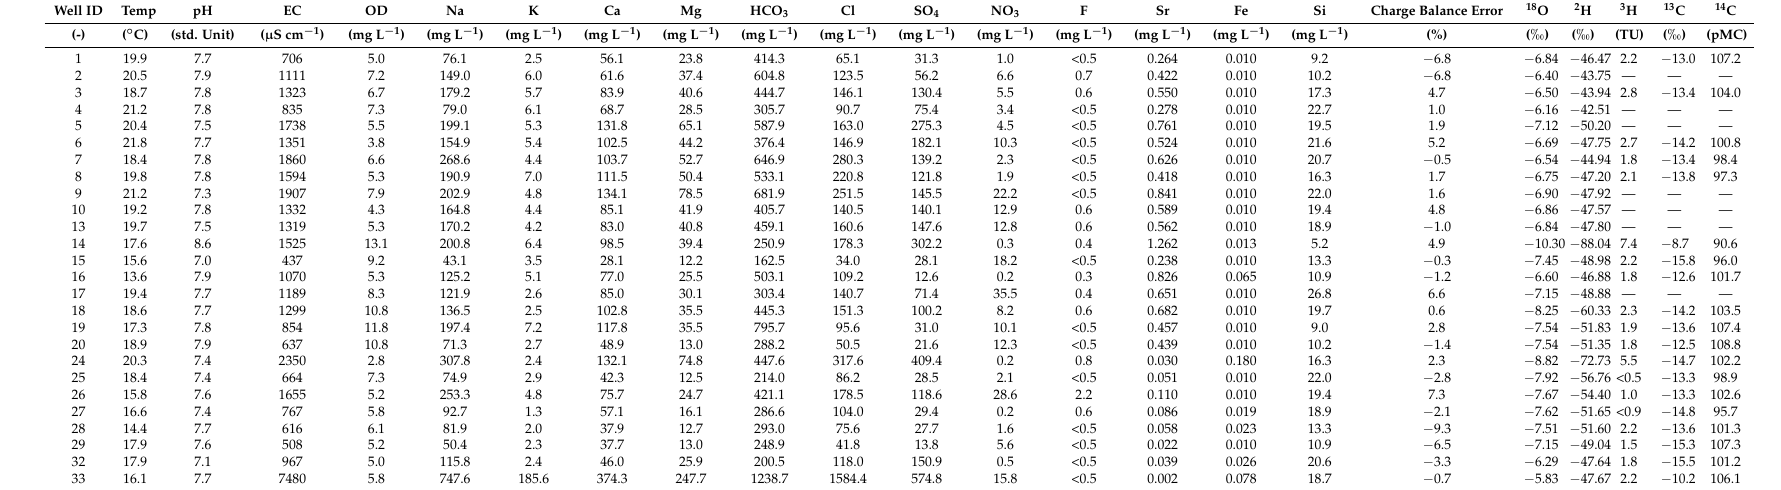
Table 1. Physicochemical parameters, chemical concentrations, charge balance error, stable isotope ratios and isotopic activities. WellID